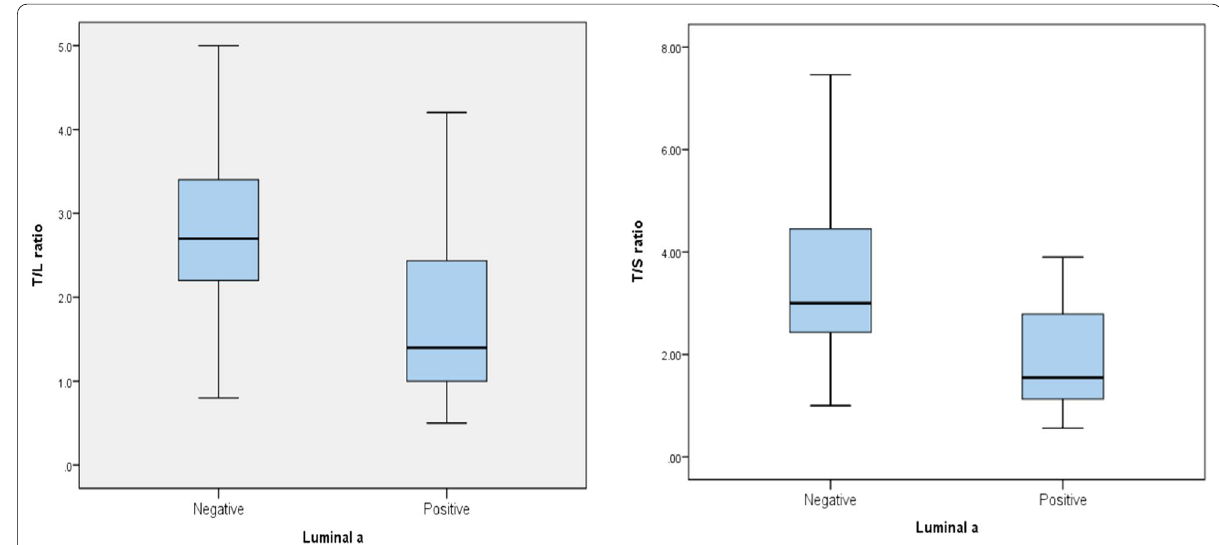
Fig. 4 Relation between the TLR and TSL and luminal a molecular subtype